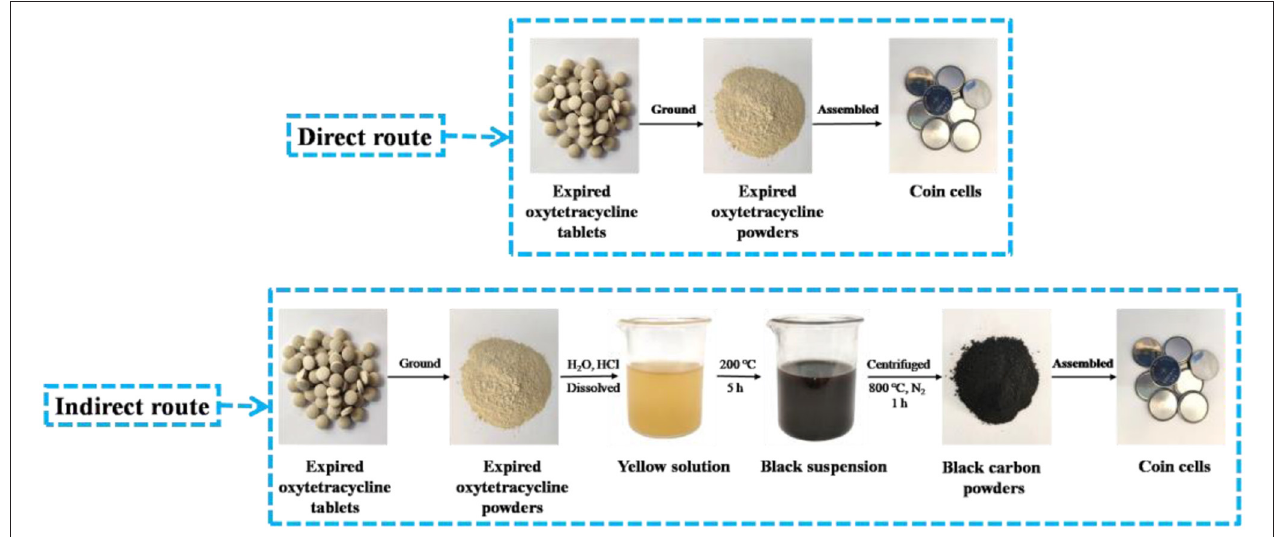
FIGURE 1 | The direct and indirect recycling routes of expired